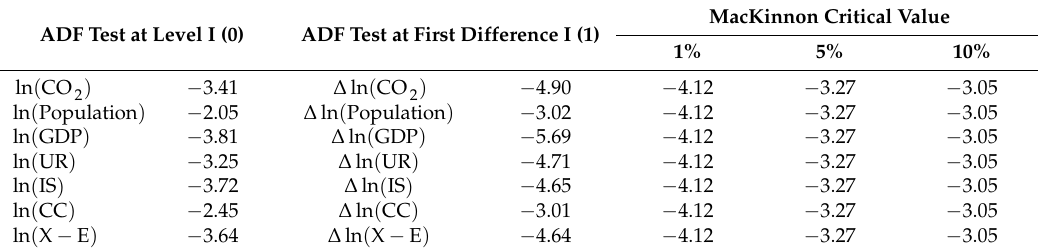
Table 1. Unit root test at Level I (0) and First Difference I